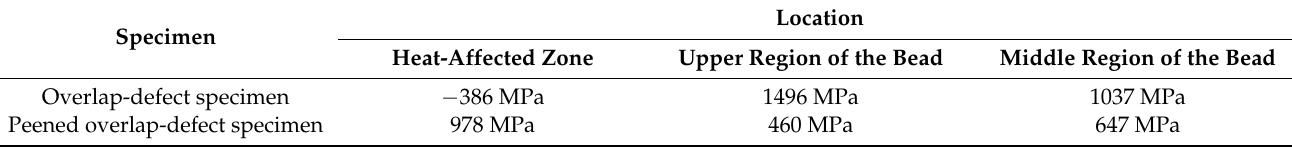
Table 4. Residual stress measurements of overlap-defect and peened test pieces.